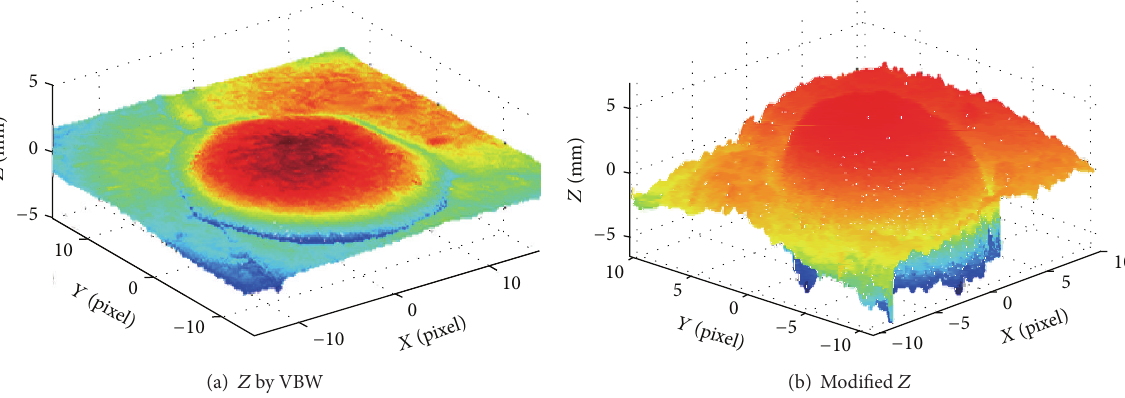
Figure 11: Result for endoscope images.